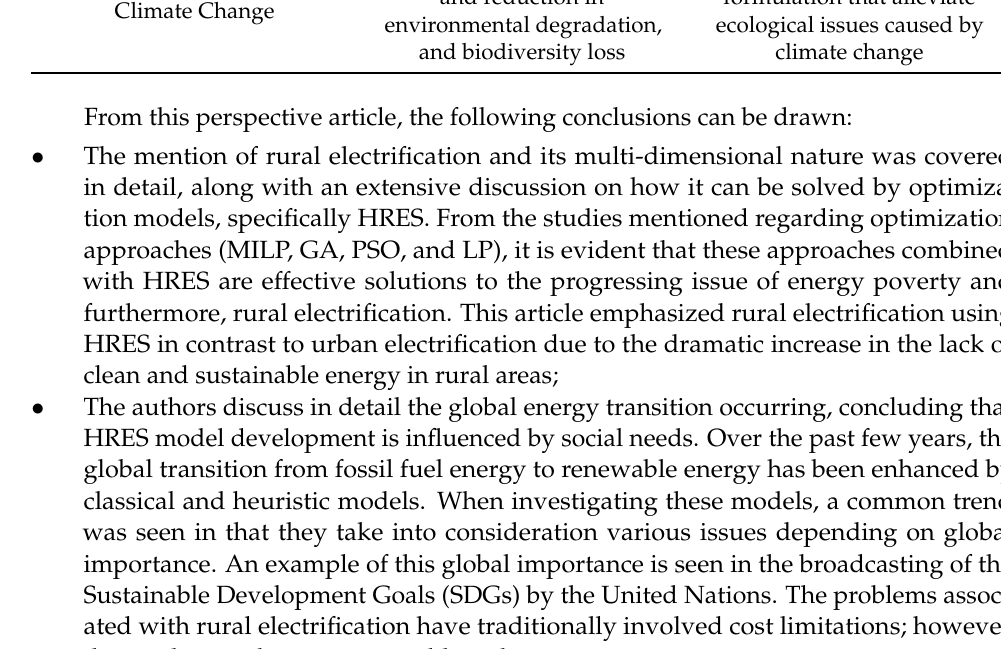
Table 2. Description of modeling challenges and perspectives discussed with respect to the associ- ated themes. Theme Challenge Perspective New advancements in Accurate representation of Technological Advancements computational new technologies in HRES techniques/formulations New advancements in model Provide sustainable, clean Energy Poverty formulations that include rural electrification social benefit factors Optimization